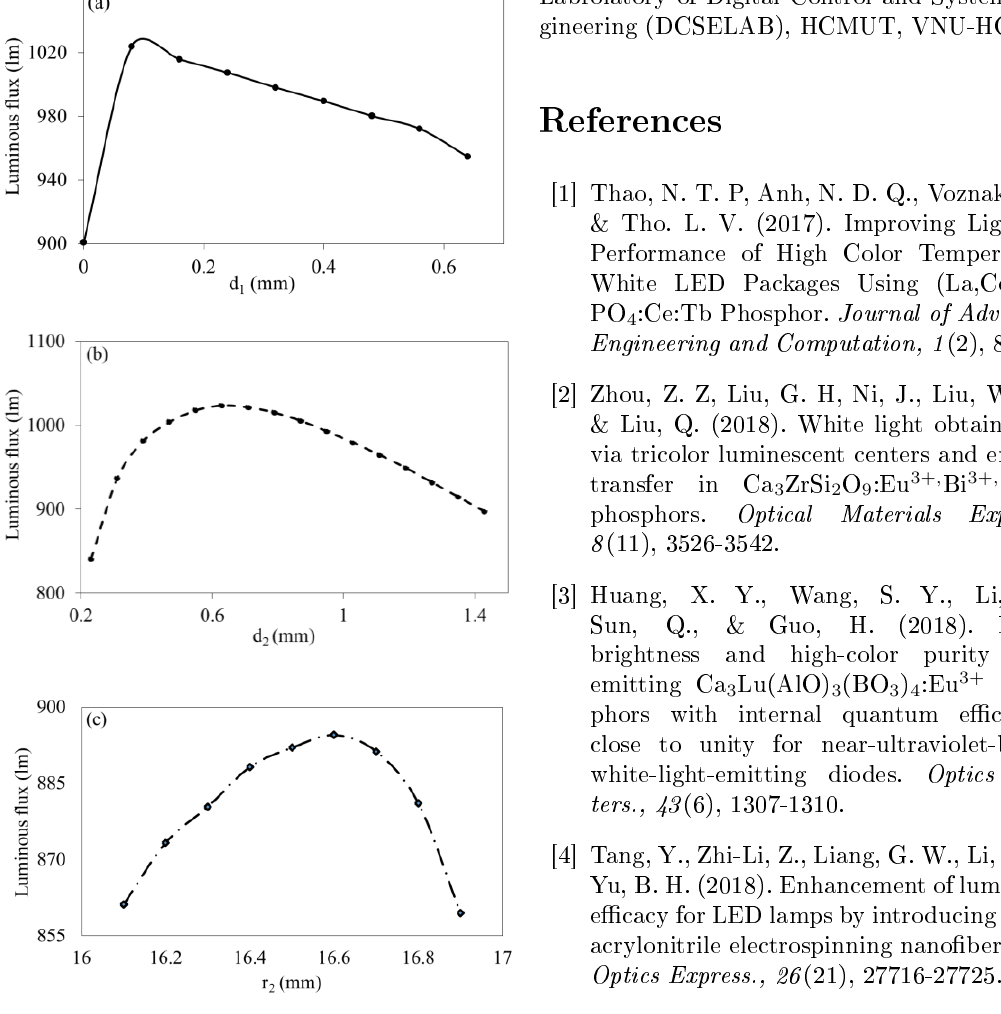
Figure 3 : Emission spectra of dual-layer phosphors: case of d ; (b) case of d and (c) case of r 1 2 2